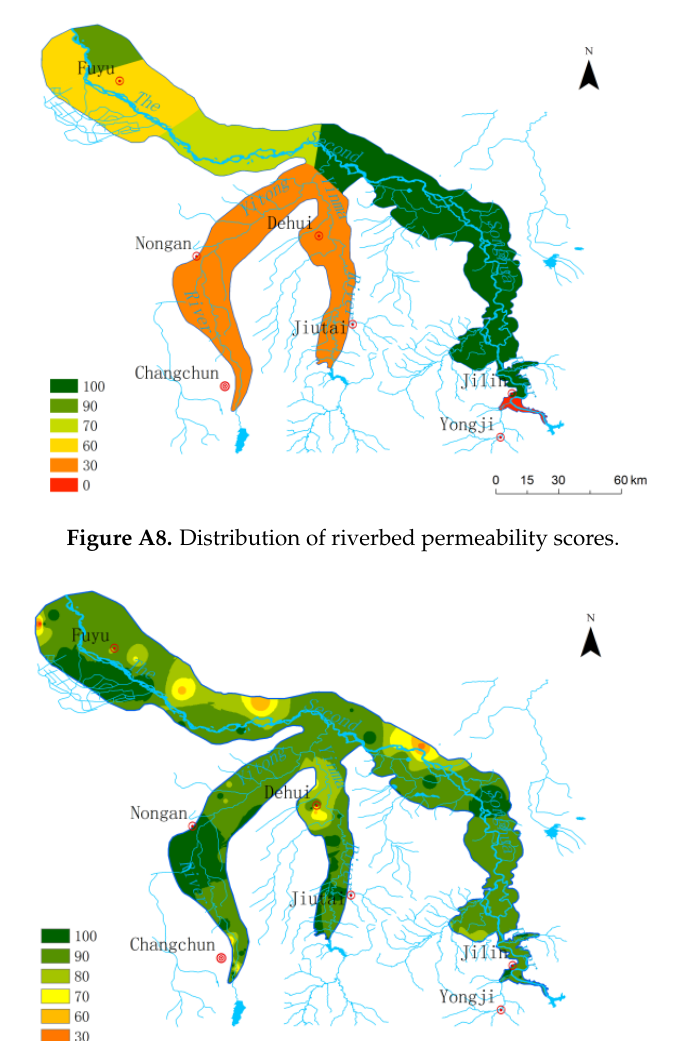
Figure A7. Distribution of scores for the possible.